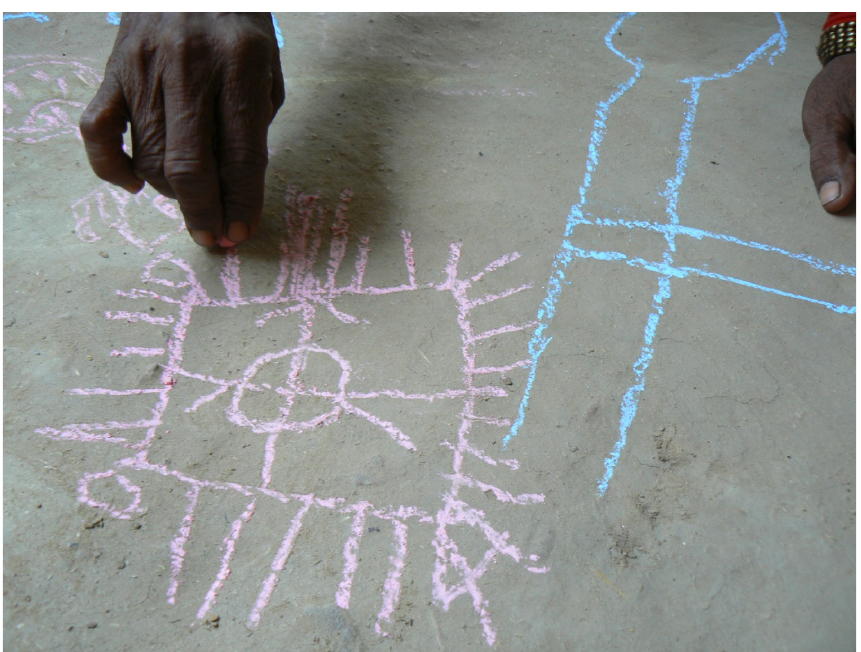
Figure 2: Bhuiyan Dalit woman sketching badka kuan (main village well) covered with thorny branches (May